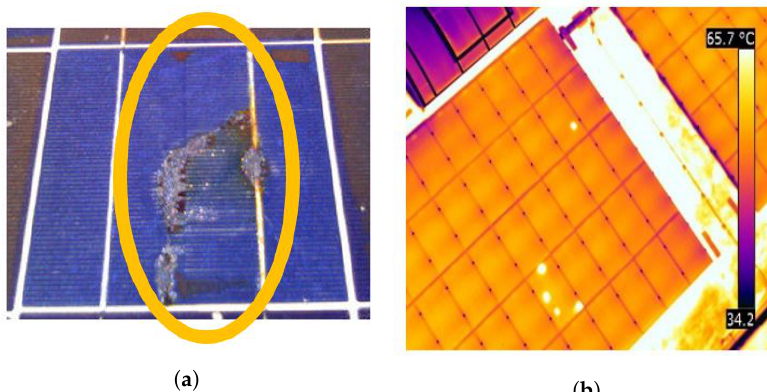
Figure 2. ( a ) Cell damage related to a hot spot; ( b ) an example of hot spot cells captured by an infrared